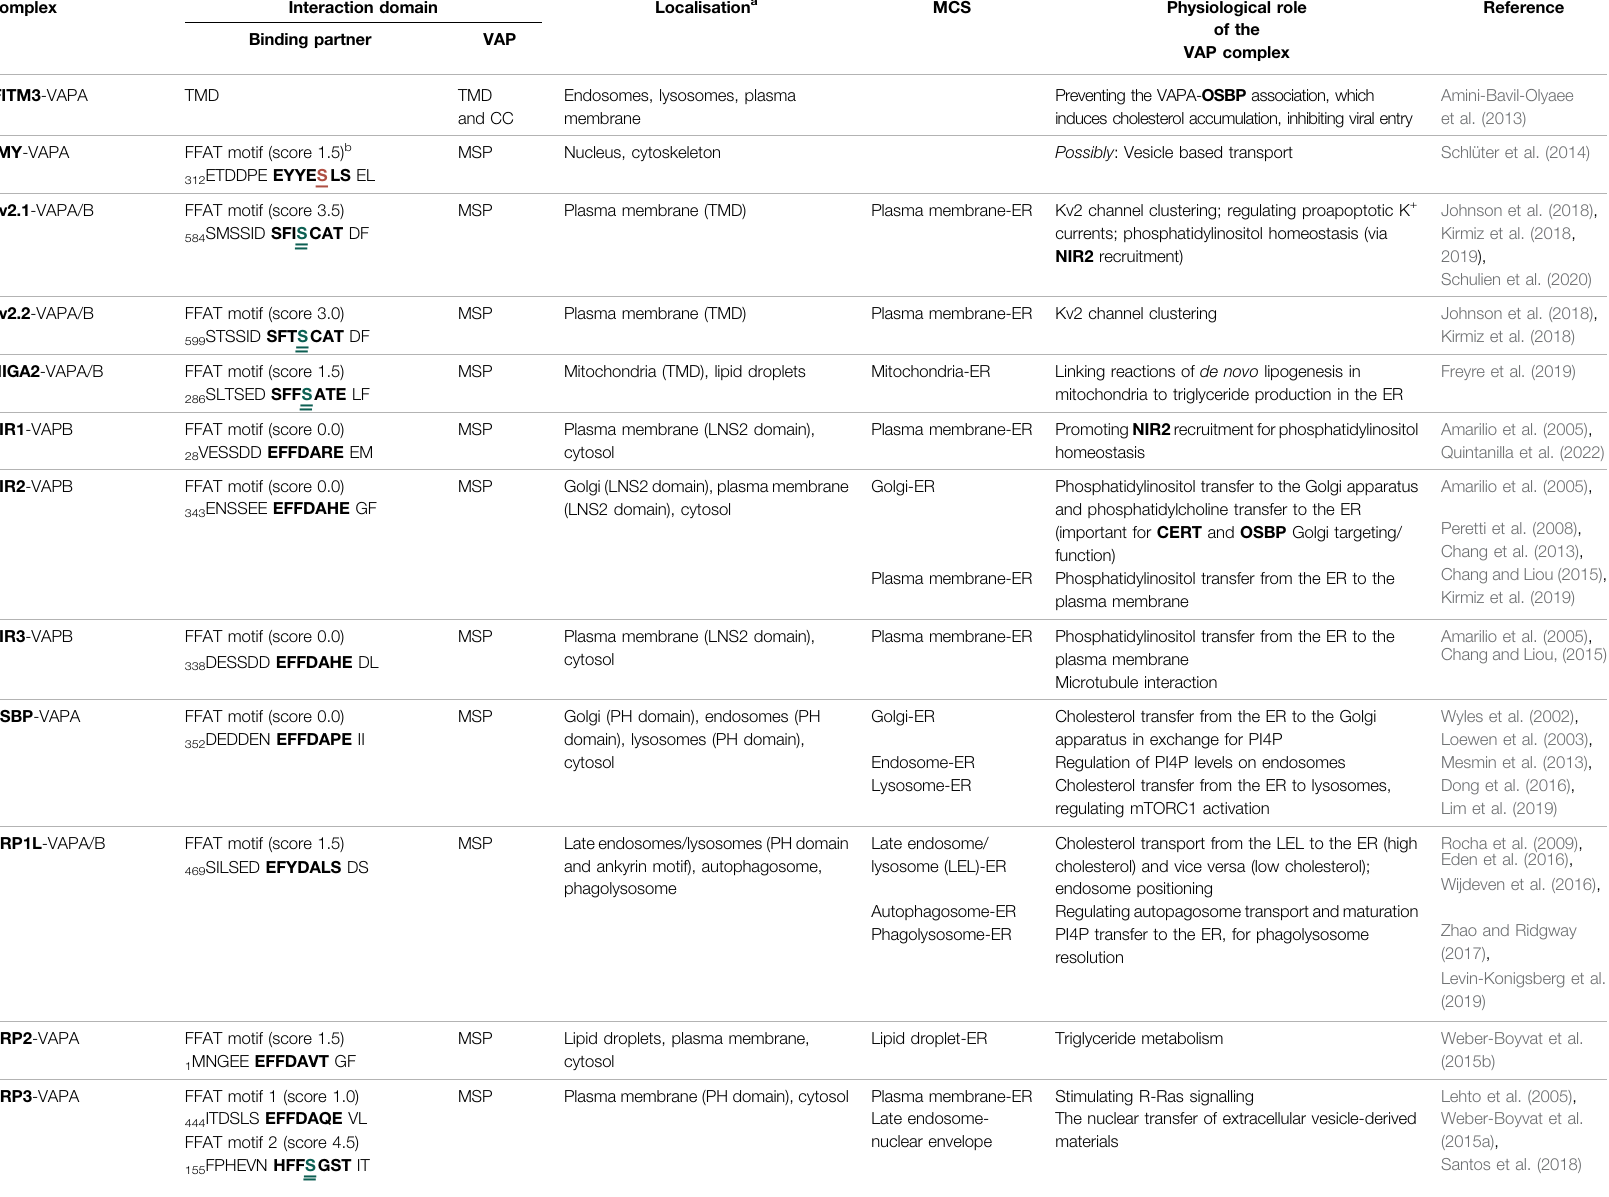
TABLE 1 | ( Continued ) An overview of experimentally con fi rmed VAP binding partners in mammalian